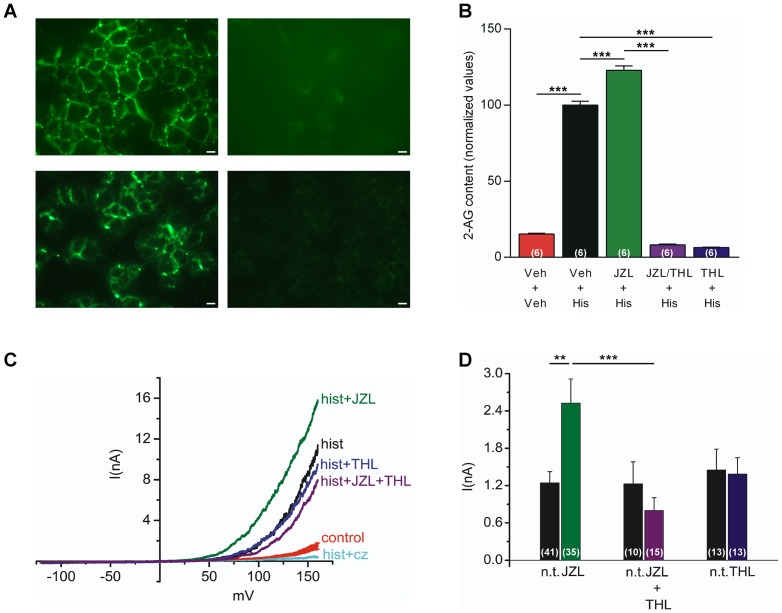
Contribution of 2-arachidonoylglycerol to TRPV1 activation evoked by stimulation of phospholipase C-coupled histamine H1 receptors in HEK293 cells.(A) Monoacylglycerol lipase (MAGL) expression in HEK293 cells, as shown by immunocytochemistry. Upper and lower left images show staining with human MAGL antibodies from Abcam and Pierce Biotechnology, respectively. Right hand images were obtained after incubation of the primary antibodies with respective blocking peptide. (B) Histamine (His, 100 µM) increased the content of 2-arachidonoylglycerol (2-AG) in HEK293 cells transiently expressing the phospholipase C-coupled histamine H1 receptor. Incubation (30 min) with the MAGL inhibitor JZL184 (JZL, 10 µM) further increased the 2-AG content, whereas the diacylglycerol lipase (DAGL) inhibitor tetrahydrolipstatin (THL, 10 µM) prevented the histamine-induced 2-AG increase. The 2-AG content was normalized to the average 2-AG content induced by histamine in vehicle-treated HEK293 cells in each experiment. The results are presented as mean ± s.e.m (n = 6). One-way ANOVA followed by Bonnferroni's post hoc test was used for comparing groups of data. (C) Current-voltage relationships in HEK293 cells transiently co-expressing TRPV1 and the rat histamine H1 receptor before (red trace) and after (black trace) exposure to histamine 100 µM in the absence and presence of JZL184 (10 µM), THL (10 µM), JZL184 plus THL (each 10 µM) or Cz (10 µM). The control trace shows the average current with error bars obtained from 119 cells. (D) The mean current amplitude elicited by histamine at a test potential of +100 mV in non-treated (n.t.) cells and in cells treated (at least 20 minutes) with enzyme inhibitors. Data are presented as mean ± s.e.m (n = 6–8). Kruskal-Wallis one-way ANOVA followed by Dunn's post hoc test was used for comparing groups of data. **P<0.01, ***P<0.001.